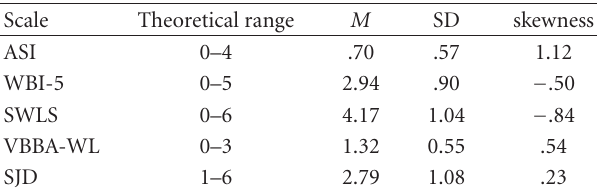
Table 1: Descriptive statistics for